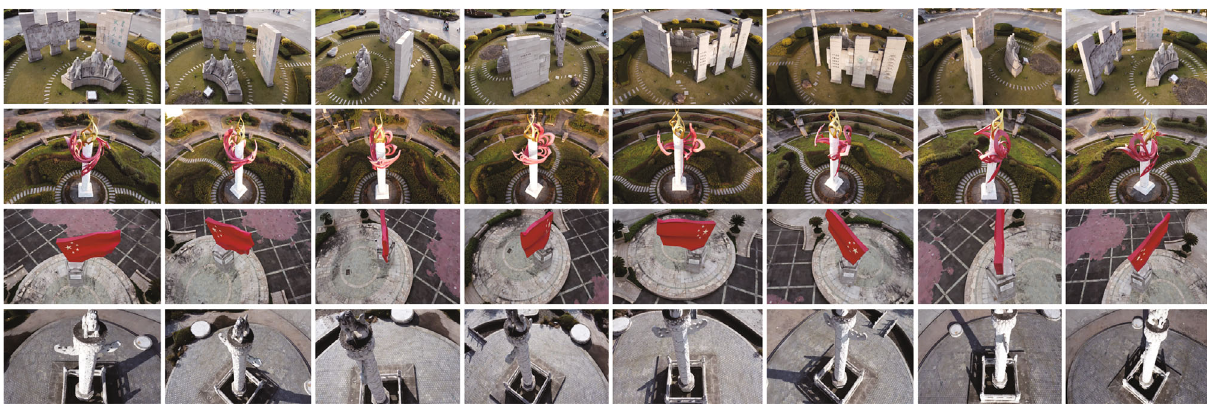
Figure 2: Partial image acquisition data from di ff erent angles (the rotation angle from left to right in order is 0 ° , 45 ° , 90 ° , 135 ° , 180 ° , 225 ° , 270 ° , and 315 °